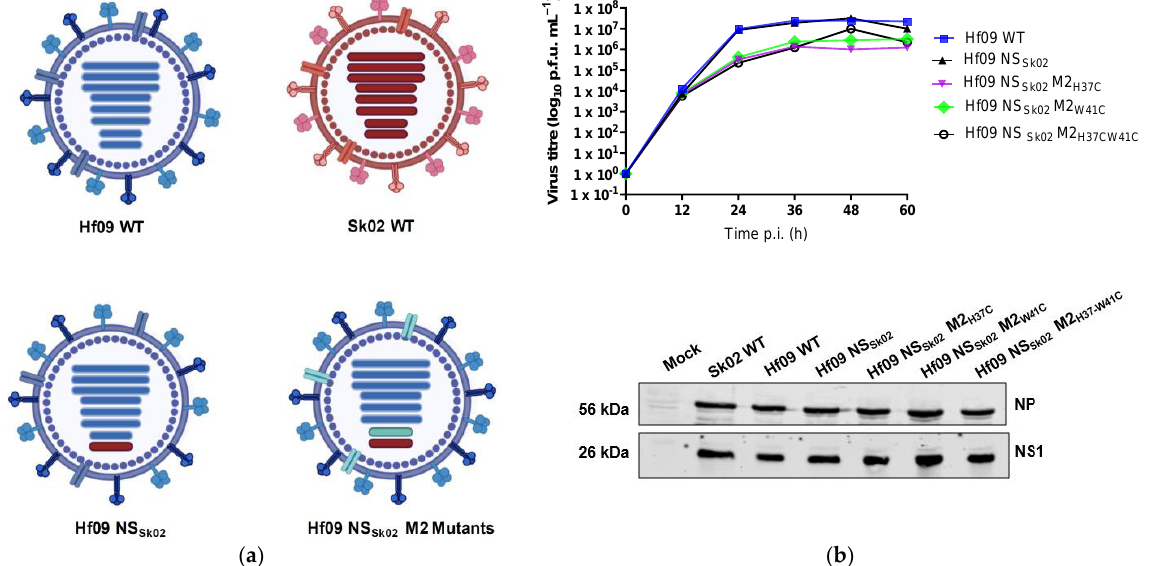
Figure 5. Generation of Hf09 NS Sk02 virus reassortants. ( a ) Schematic diagram of genome composition of WT and mutant viruses. Hf09 NS SK02 virus has the background of Hf09 WT (Blue) with NS segment replaced with that from Sk02 (Red) virus. Hf09 NS Sk02 M2 mutant viruses (turquoise) are derivatives of Hf09 NS SK02 wherein the 7th segment contains various mutations. ( b ) MDCK- M2 cells were infected with Hf09 NS Sk02 WT and the respective Hf09 NS Sk02 M2 mutant viruses at an MOI of 0.001. The supernatant collected at different time points was subjected to plaque assay. Viral protein expression from infected cells (MOI of 1, at 36 h.p.i.) was determined by Western blotting (lower panel) (p.f.u.—plaque forming unit; time p.i.—Time post infection). Using these viruses, we conducted a bioluminescence resonance energy transfer ( BRET) assay to analyze how the M2 mutations would affect the NLRP3 conformational change.